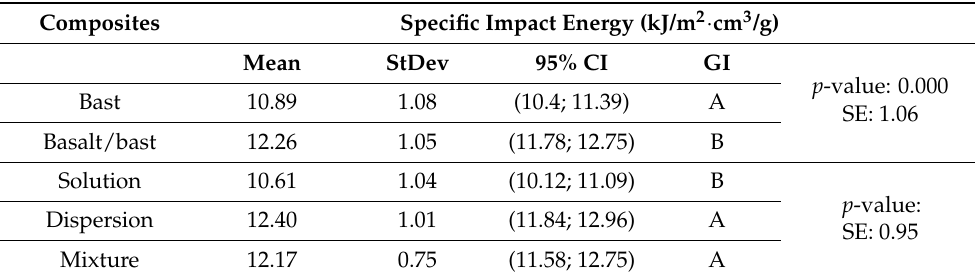
Table 10. Analysis of the equality of means using one way analysis of variance—specific impact energy.